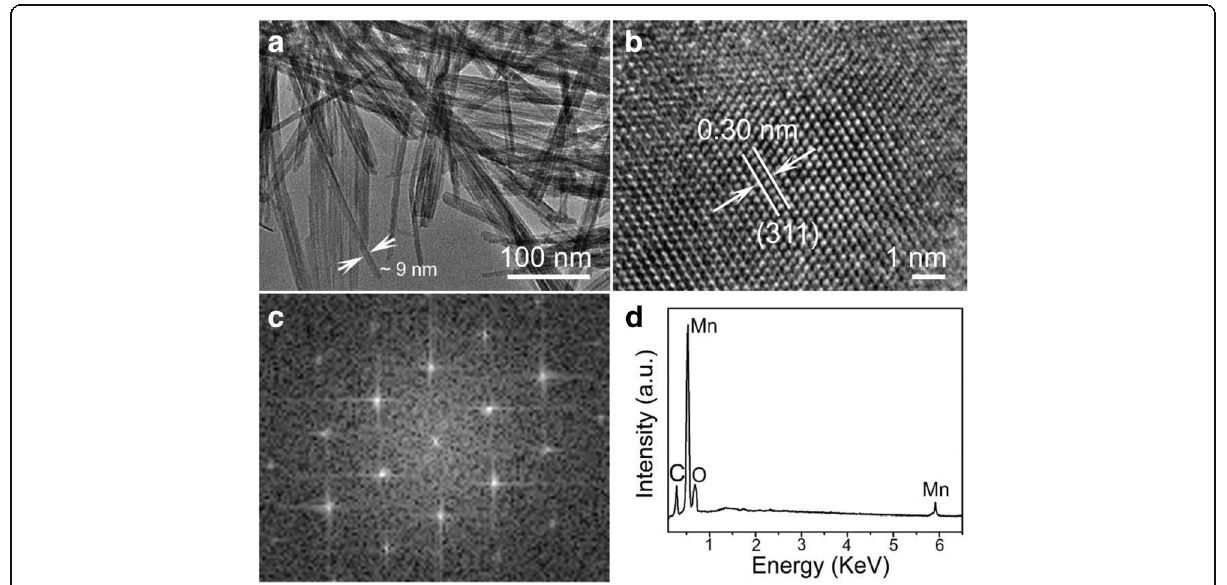
Fig. 2 a TEM image of the ultrafine MnO 2 nanowires with a diameter of ~9 nm. b HRTEM image of a MnO 2 nanowire and c its corresponding FFT pattern. d EDX of the MnO 2